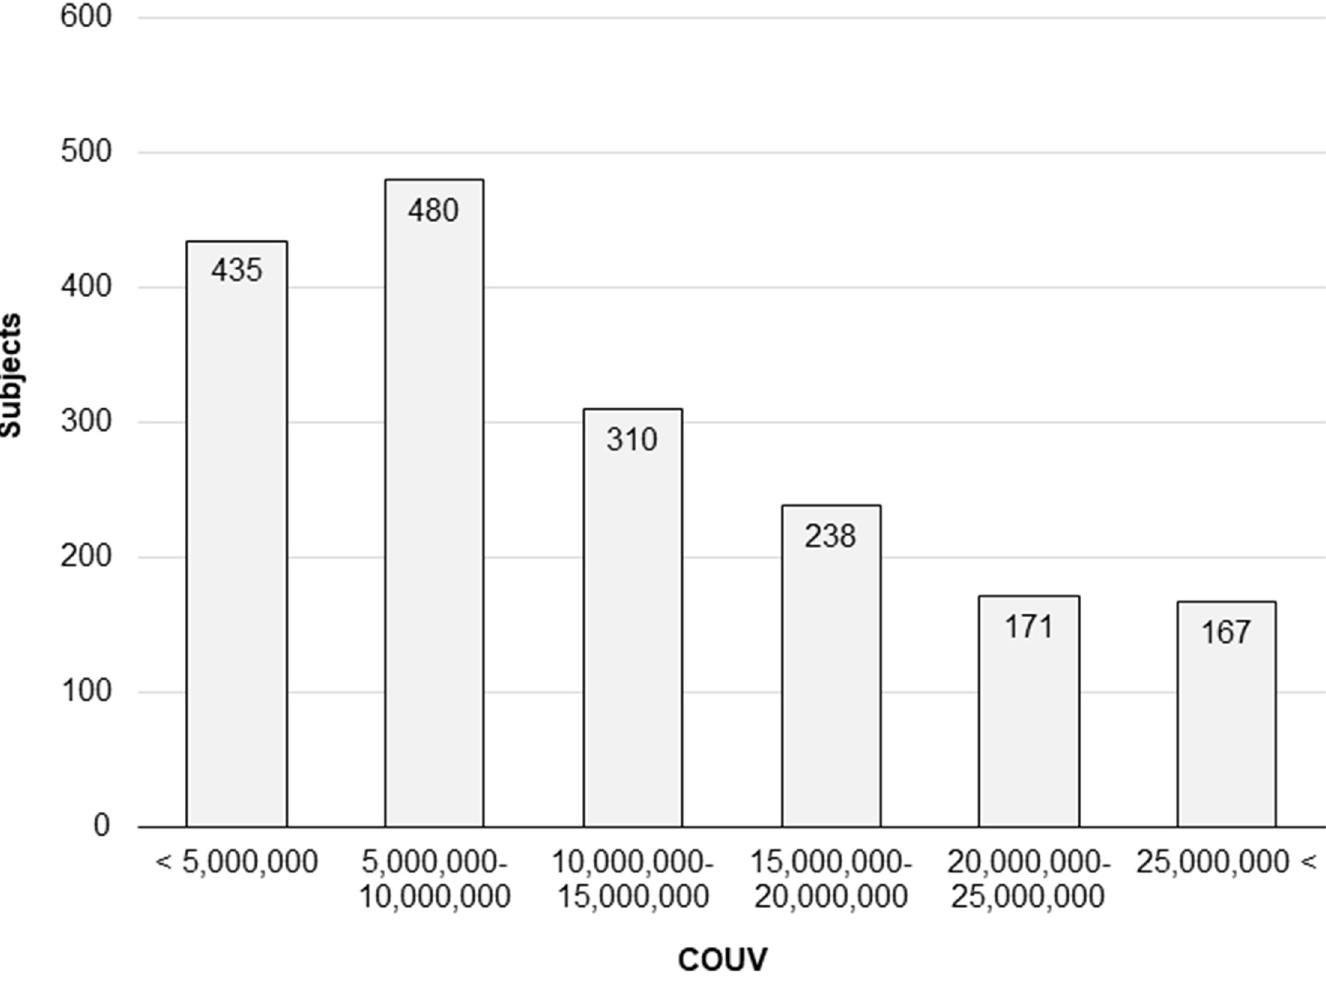
Fig 3. COUV distribution among subjects.